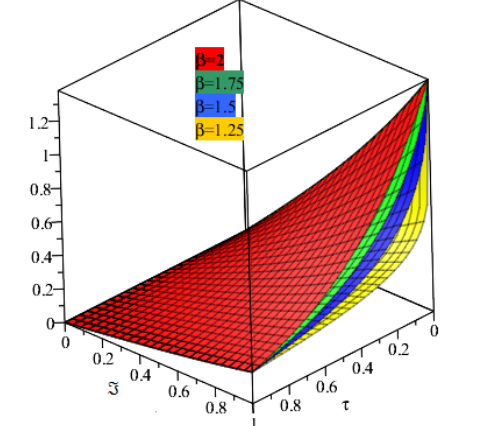
Figure 14. The solution graph at different fractional order β . of Example